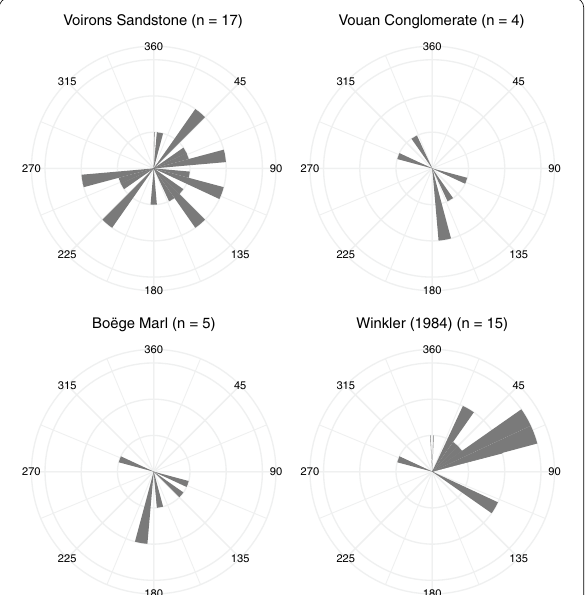
Fig. 8 Dispersal pattern based on flute casts and groove casts for the three stratigraphic units of the Voirons Flysch, and corrected for a 20° counter‑clockwise rotation. Data are compared to the dataset of Winkler (1984a) for the undifferentiated Voirons Flysch. See text for explanations. Note the overall eastward direction of the